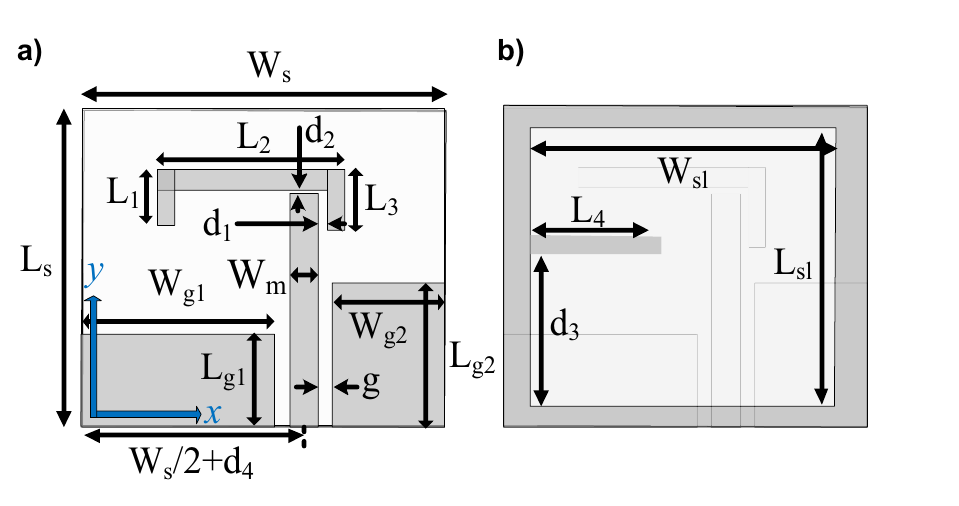
Figure 12. Wide-slot CP antenna 49 , parameterized view: ( a ) front, ( b )